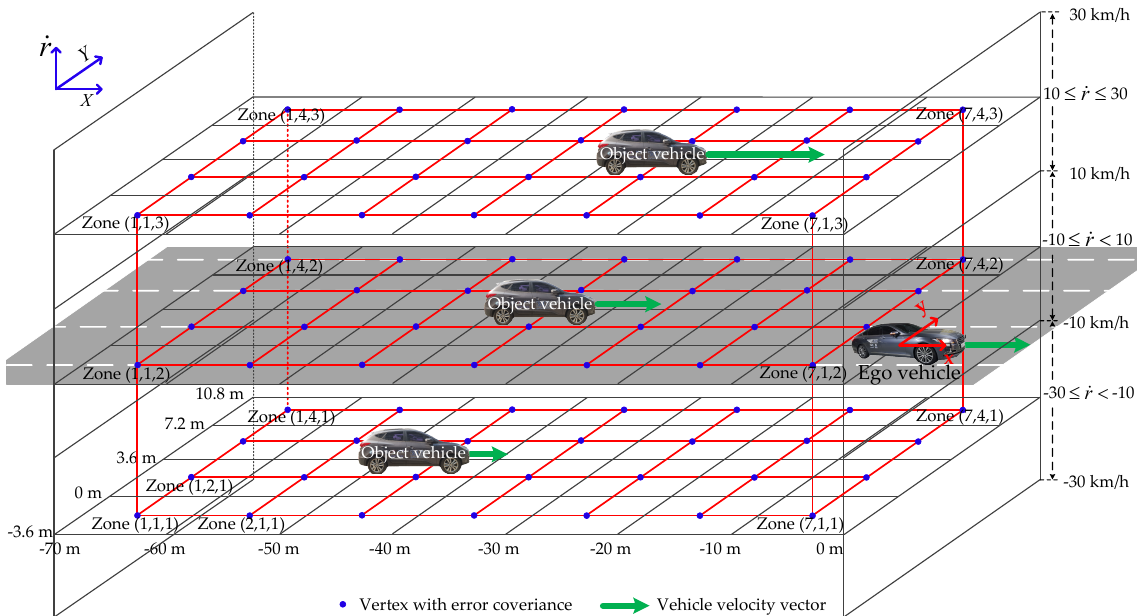
Figure 2. Example of a divided occupancy zone configuration: the occupancy zone is created by taking into account the detectable area of the radar, which is divided by the x-axis and y-axis based on the vehicle coordinate frame. The z-axis is divided by data sets for relative velocity. The center point of each divided black quadrangle zone becomes each vertex of the red quadrangle (feasible set for error covariance). Then, the error characteristics analyzed in each zone are stored in each